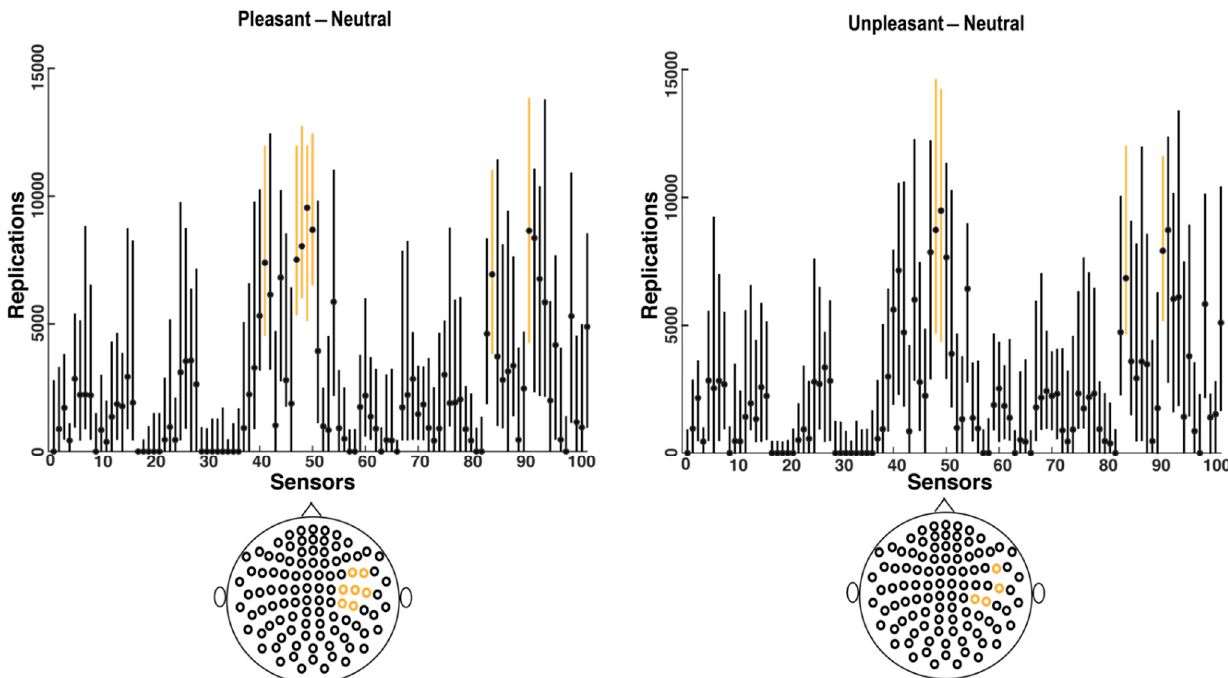
Figure 4. Forest plot for all selected sensors by bootstrapping over all participants. Vertical lines show the 95% confidence intervals for the selected sensors based on 25,000 bootstrapping replications for all participants, with the median values represented by black dots. Orange lines show the most frequently selected sensors for all participants with the highest median and the highest lower limits in confidence intervals. The bottom graphs depict the location of the selected sensors (orange lines in the top figures) which are located in the right temporal and parietal regions.